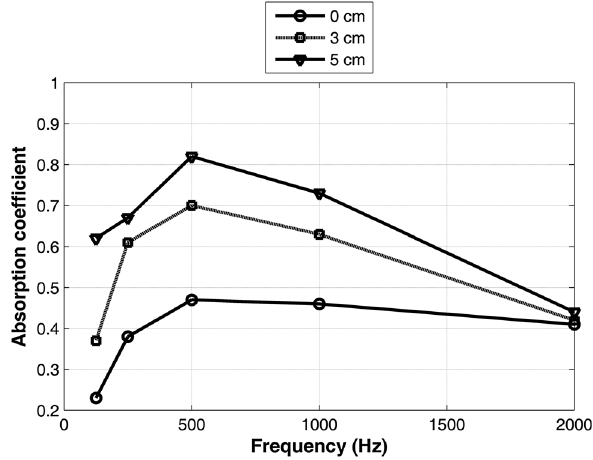
Fig. 10 Absorption coefficients of the concrete A1 with a certain air